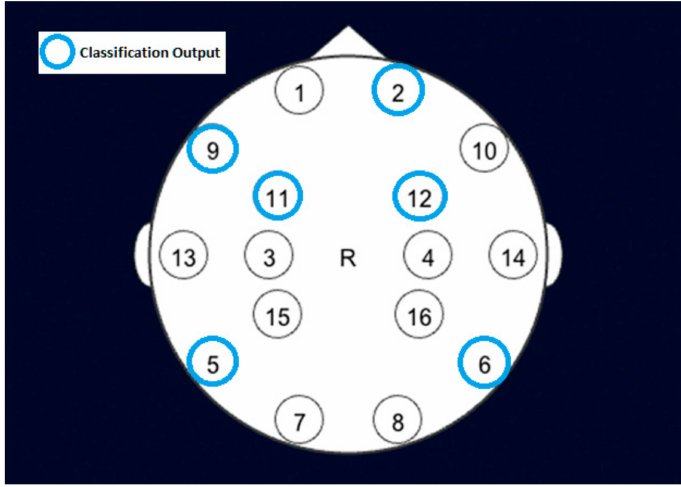
Figure 19. BCI Channels (EEGs) and Classification